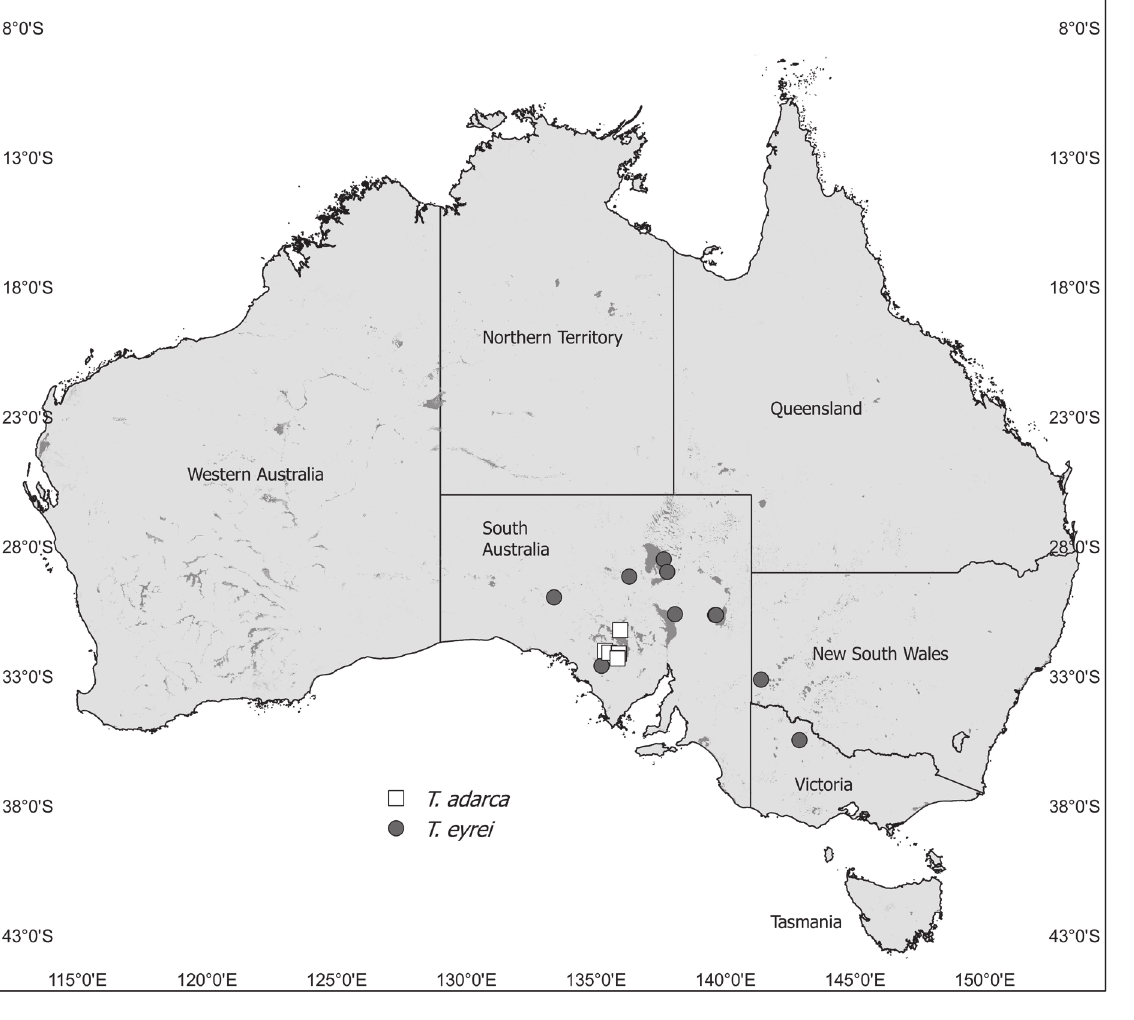
Fig. 25. Tetralycosa adarca sp. nov. and T. eyrei (Hickman, 1944), distribution records